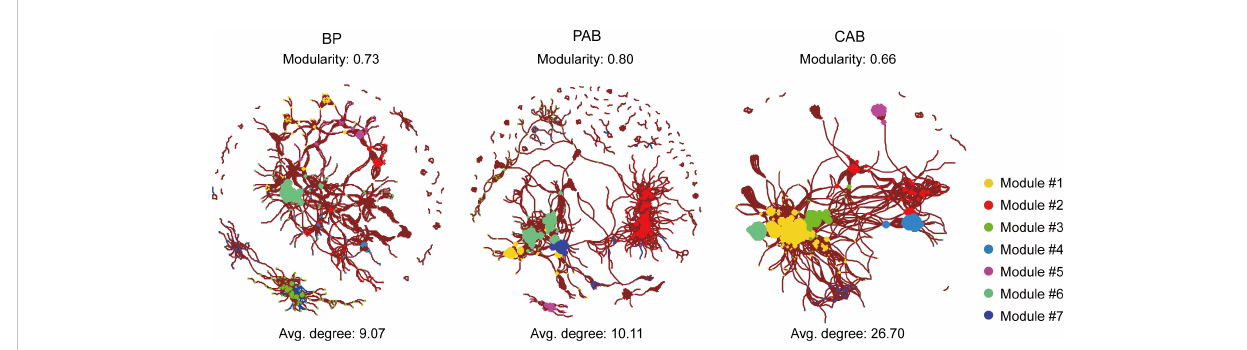
FIGURE 7 Co-occurrence network of bacterial relationship from BP (bacterioplankton), PAB (particle-attached bacteria), and CAB (colony-attached bacteria) created with a Spearman ’ s coef fi cient threshold of ± 0.7 and an adjusted p -value threshold of 0.01. Each node represents bacterial genus and the node size is proportional to the value of degree, lines connecting two nodes indicated the interactions between them. Red lines represent a positive signi fi cant correlation and blue lines represent negative signi fi cant correlation. Node color represents the bacterial distribution modules.